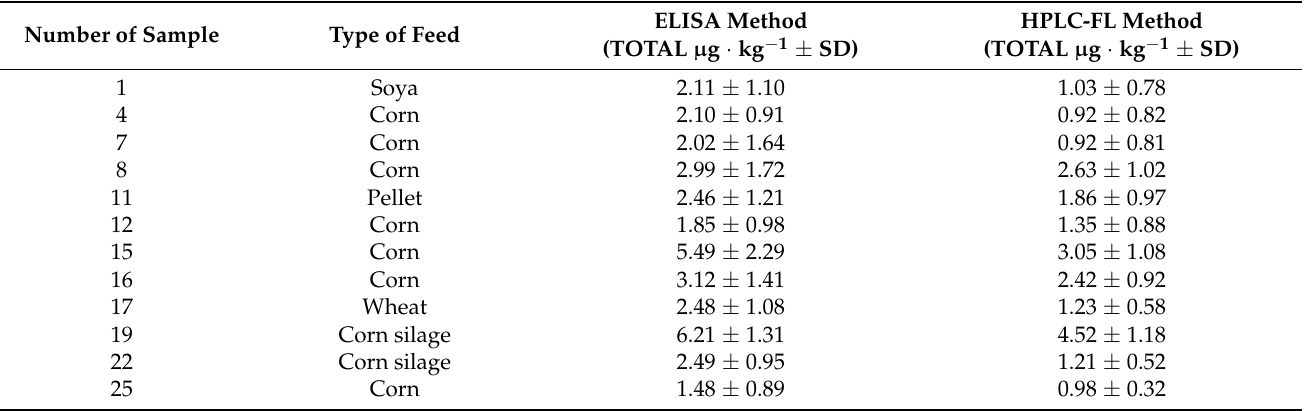
Table 4. The results from the analysis of the samples in which AFs values were above LOQ as determined by ELISA and HPLC-FL